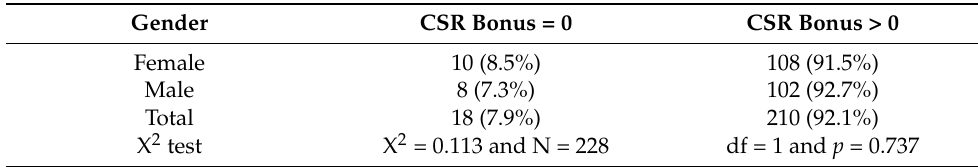
Table 2. Contingency table H 0 gender—the frequency of non-CSR bonus payers is the same by males and females (gender does not matter).